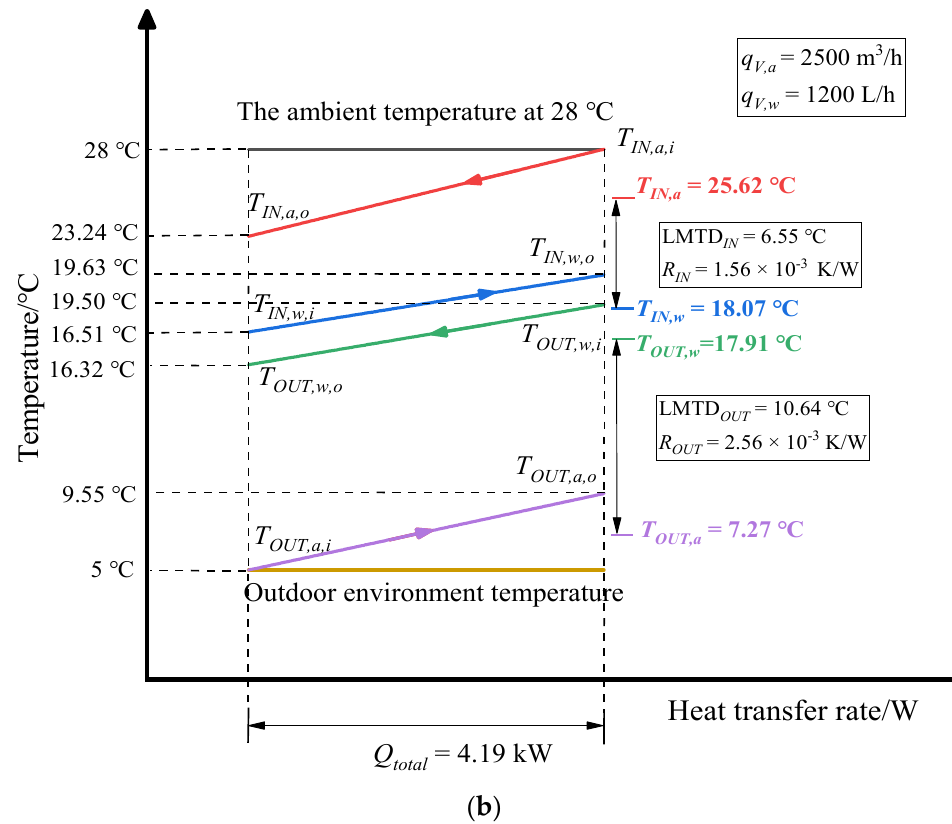
Figure 10. Distribution diagram under different outdoor temperatures: ( a ) outdoor temperature at − 15 °C, ( b ) outdoor temperature at 5 °C.